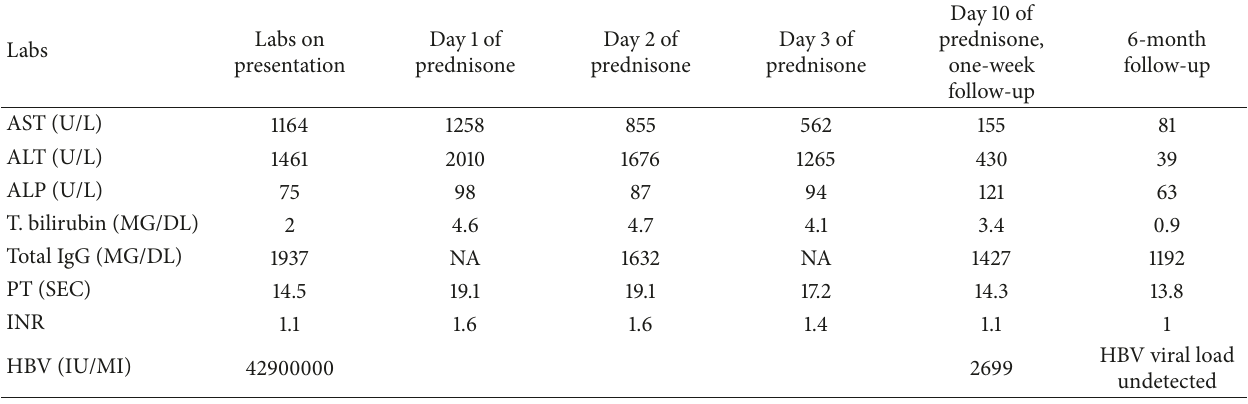
Table 1: Trend of laboratory results.